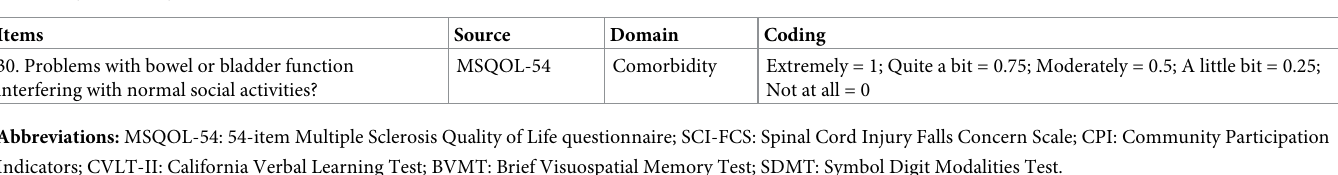
relationship between frailty index scores and disease duration (r = -0.058, p = 0.706), or age ( ρ = -0.113, p = 0.471). In an additional Spearman analysis, no correlation between frailty index